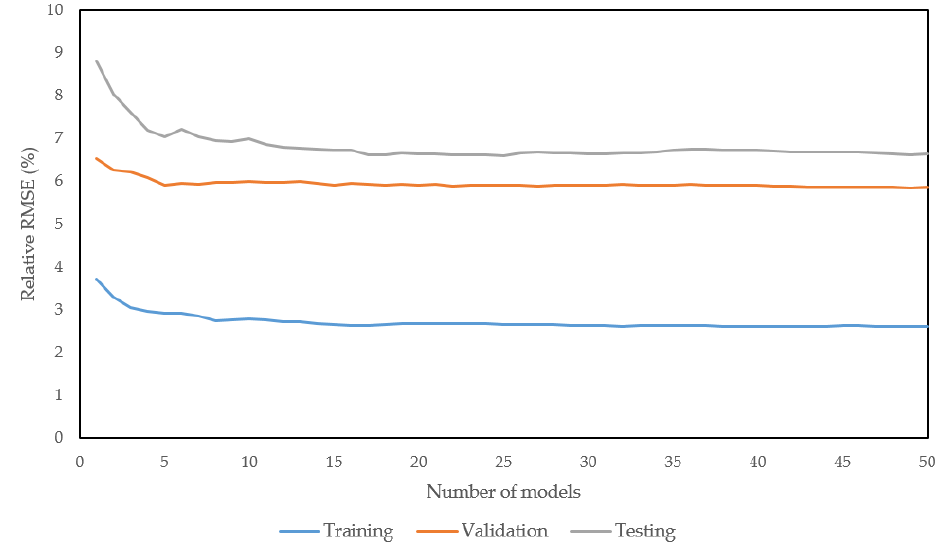
Figure 8. Variation of the percentage of relative RMSE with the number of models in the ensemble.